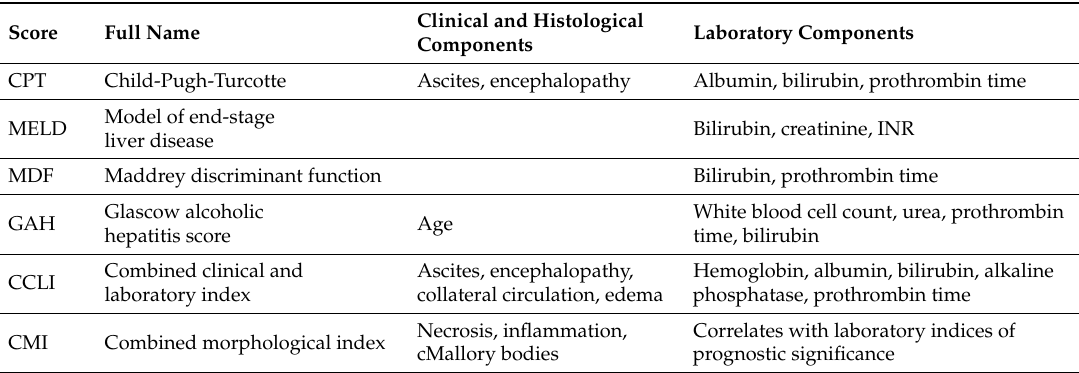
Table 3. Biomarker-based scoring systems for the severity of alcoholic liver